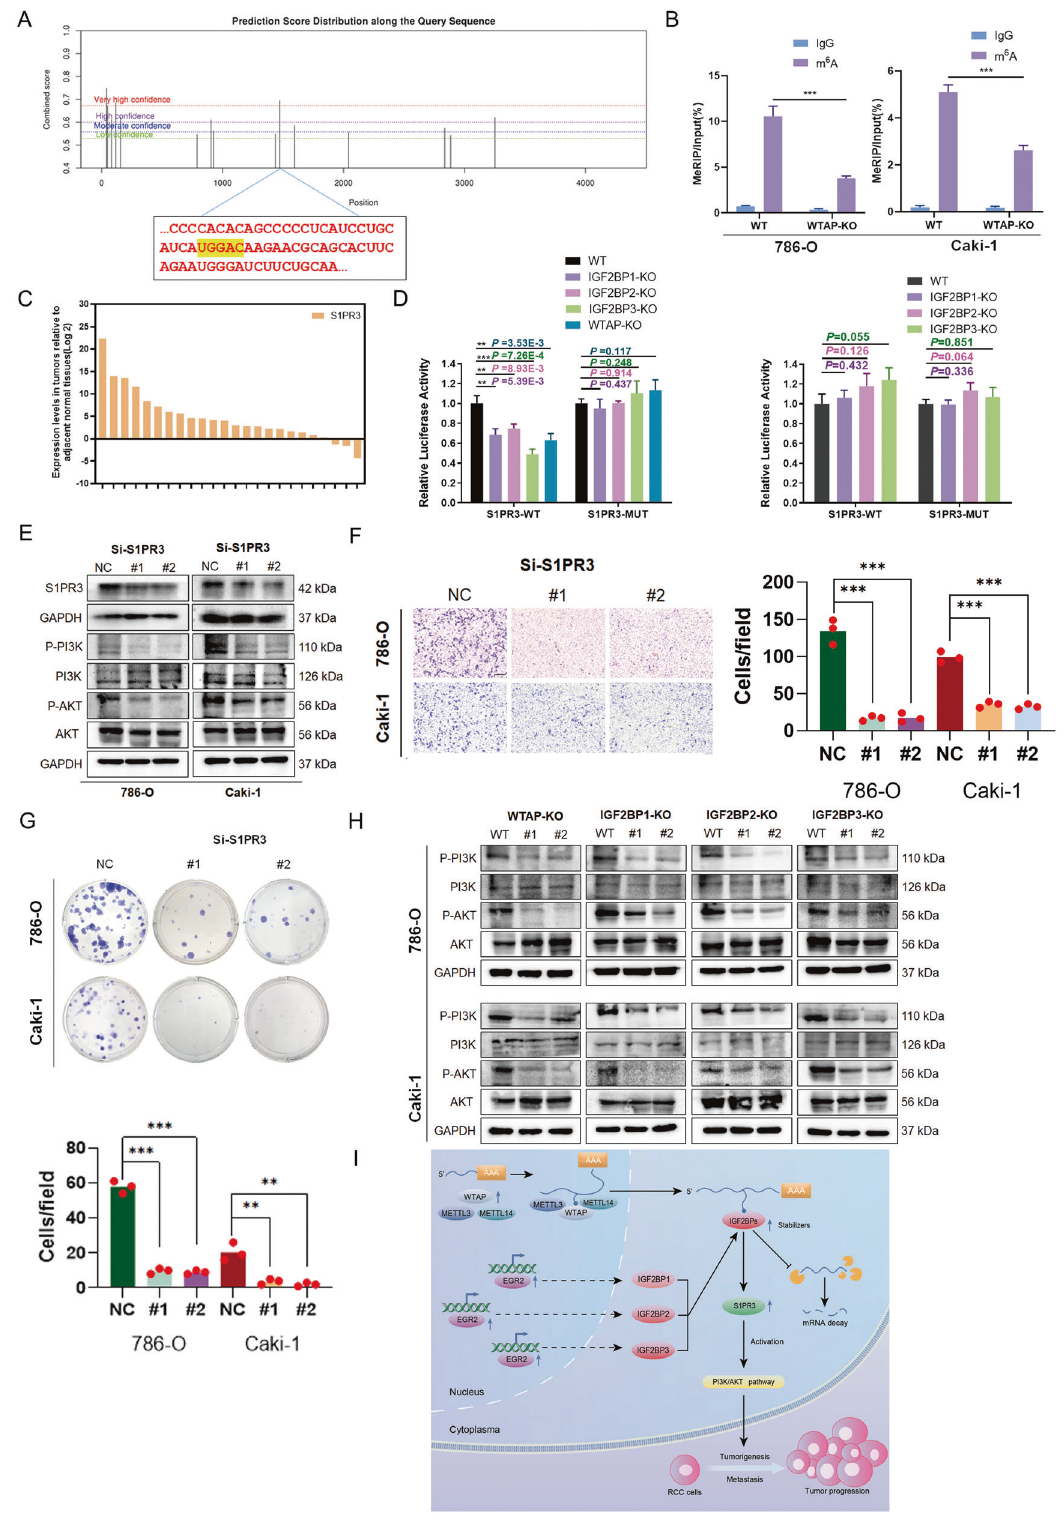
Fig. 6 WTAP-mediated m 6 A modi fi cation of S1PR3 maintains the IGF2BPs-induced regulation of RCC proliferation and metastasis. A The predicted sites in S1PR3 mRNA in the SRAMP database. B Enrichment of m 6 A modi fi cation on S1PR3 as detected by MeRIP-PCR assay. C S1PR3 were elevated in 21 (87.5%) RCC tissues relative to adjacent nonmalignant tissues. D Relative luciferase activities of S1PR3-WT of S1PR3-MUT in WTAP KO 786-O cells with IGF2BPs knockdown. E The protein levels of S1PR3 and PI3K/AKT pathway following S1PR3 knockdown. F , G Knockdown of S1PR3 markedly suppressed migration and proliferation viabilities of RCC cells. Scale bar 250 μ m. H Knockout of WTAP and IGF2BPs regulate PI3K/AKT pathway. I Schematic diagram of IGF2BP-mediated regulation of m 6 A-modi fi ed S1PR3 mRNA. Values in B and D are mean ± SEM. * P < 0.05; ** P < 0.01; *** P <